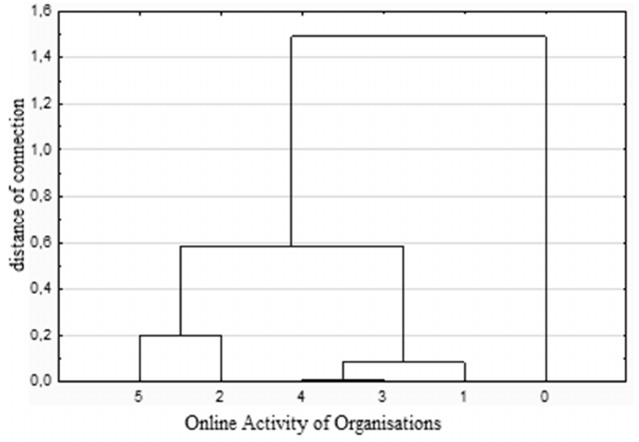
Figure 1 – Cluster analysis of companies' on-line